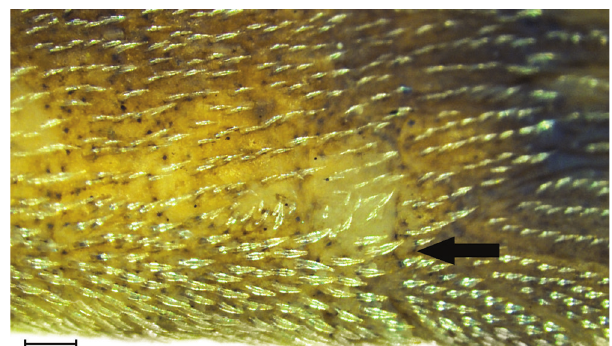
Fig. 7. Dermal plates at posterior end of caudal peduncle of Parotocinclus spilurus , topotype, UFRN 1300, male, 40.2 mm SL. Arrow indicates odontodes dorsally or posterodorsally directed and modified into a cluster. Scale bar = 1 mm.